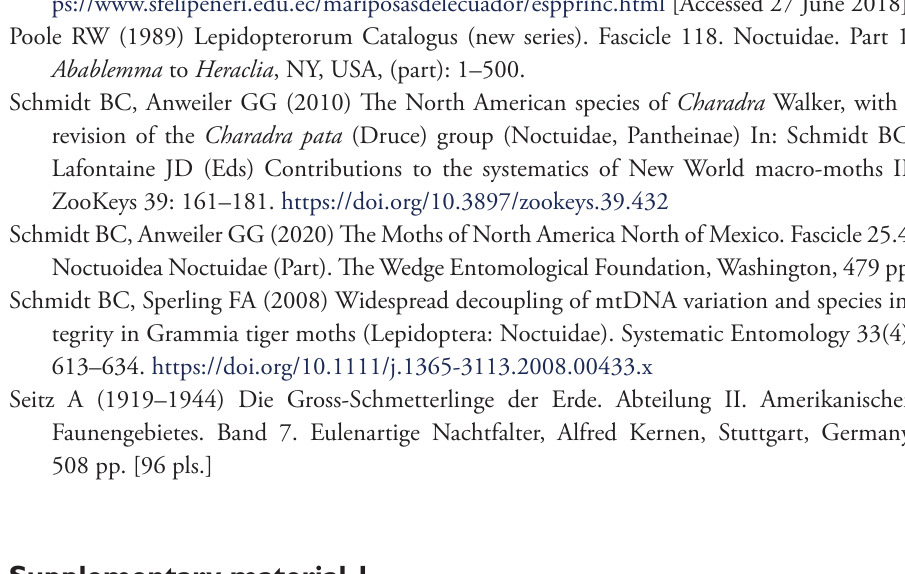
Data type: genetic